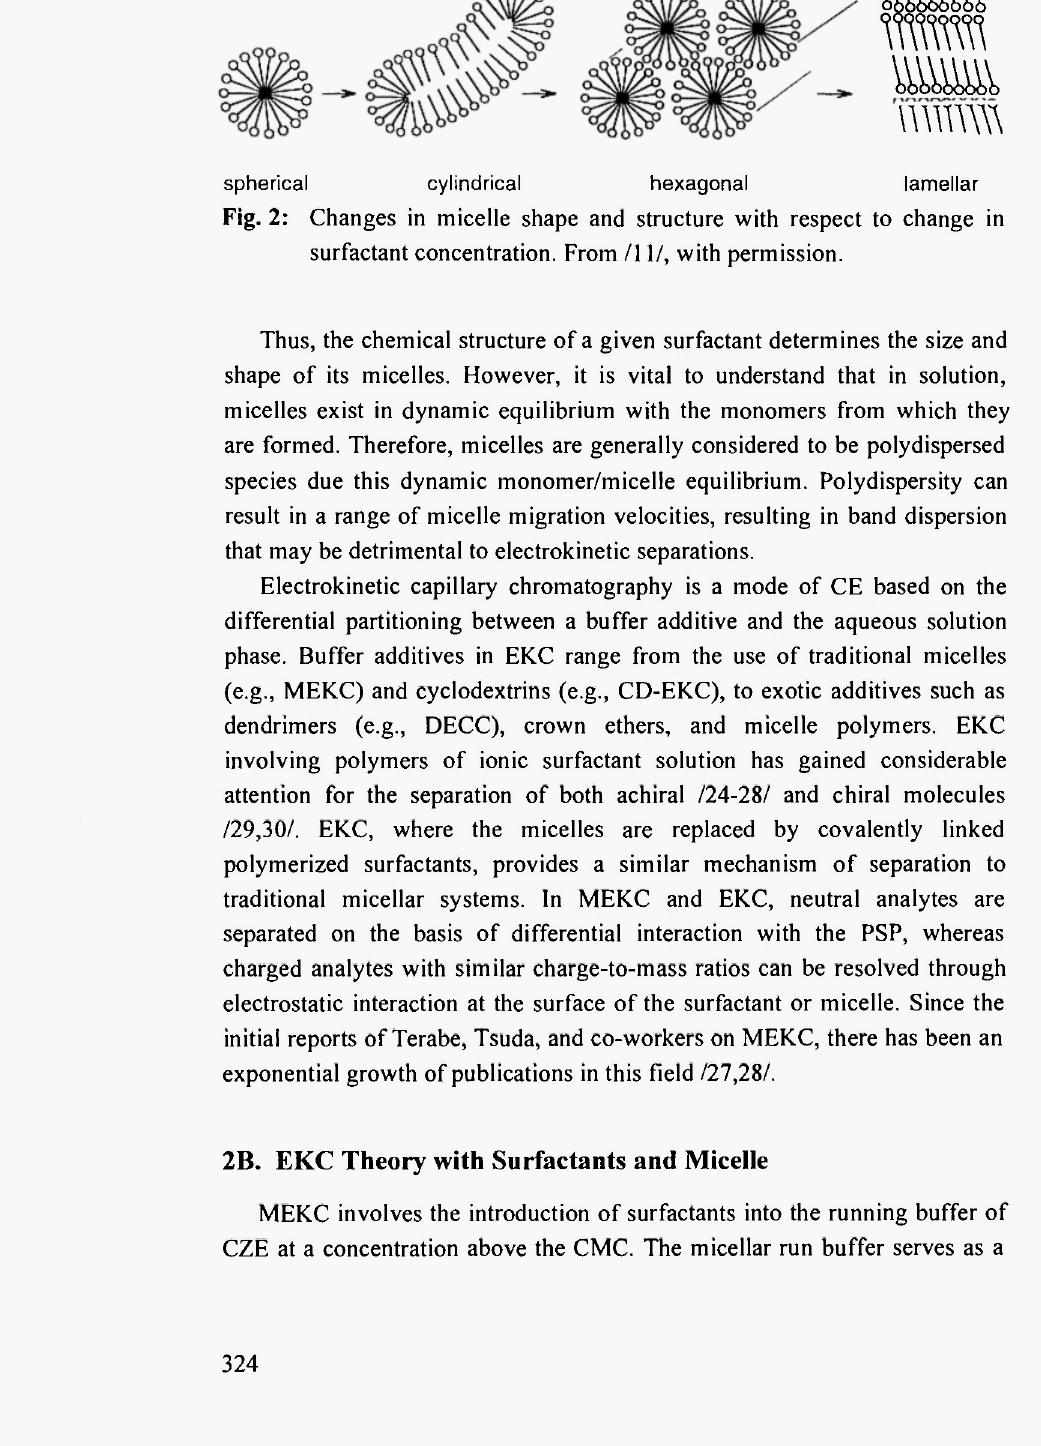
Fig. 2: Changes in micelle shape and structure with respect to change in surfactant concentration. From /11/, with